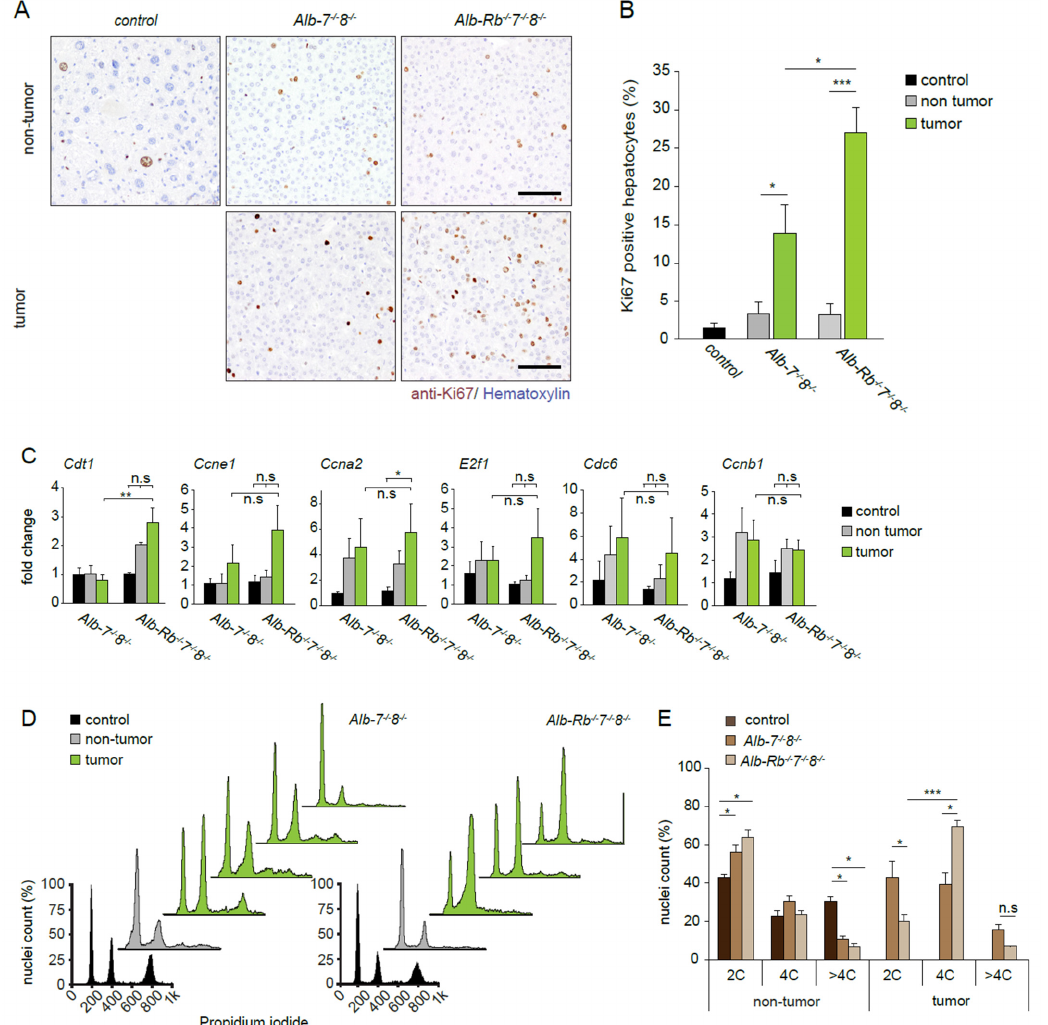
Figure 2. Combined loss of E2F7/8 and RB results in rapidly proliferating liver tumors. ( A ) Representative pictures of Ki67 showing proliferating cells in non-tumor and tumor areas of livers from the indicated genotypes. Tumors were collected at the end of life-span. Scale bars: 50 µm. ( B ) Quantification of Ki67 immunohistochemistry in 5 fields (40× objective) in tumor and adjacent non tumor areas of the livers from the indicated genotypes. Controls represent Alb-Cre negative littermates analyzed at the same time point as Alb-Cre positive ones. The data are presented as average ±SEM (1 tumor per mice was analyzed/mouse; n = 6–7 mice). ( C ) Transcript levels of E2F target genes in the indicated areas from Alb − 7 − / − 8 − / − and Alb-Rb − / − 7 − / − 8 − / − mice. Fold changes were adjusted to average of controls and Actb and Gapdh were used to normalize the expression. Data represent average ± SEM ( n = 5–6 mice). ( D ) Representative cell cycle profiles analyzed by flow cytometry of the indicated areas and genotypes. E. Quantification of nuclei from the cell cycle profiles in ( D ) Data represent average ± SEM ( n = 3–5). Data information: In ( B ) * p < 0.05, (Mann–Whitney Rank Sum test); ( C and E ) * p < 0.05, ** p < 0.01, *** p < 0.001 (One Way ANOVA).